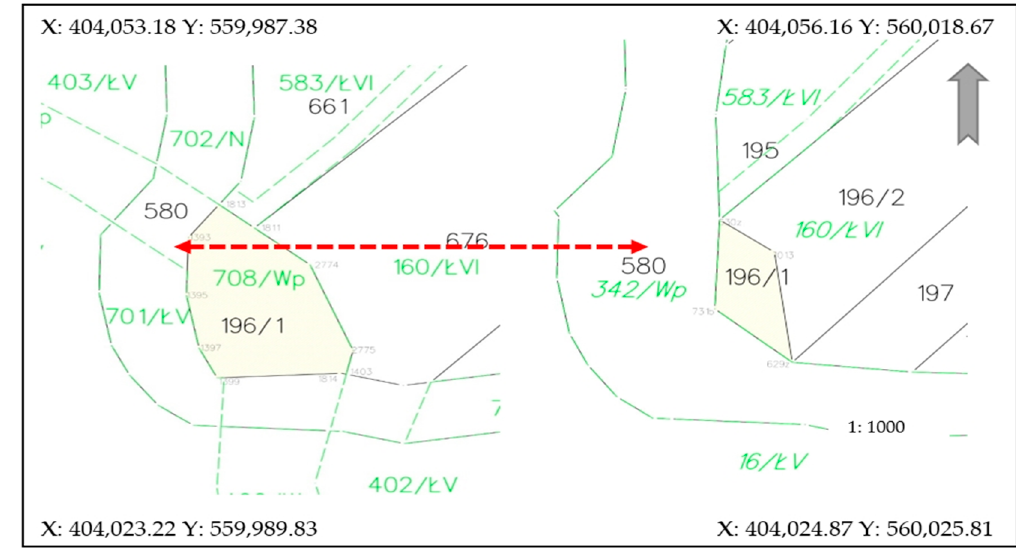
Figure 9. Change in water flow borders after cadastral data modernisation—state before and after modernisation. X, Y—coordinates of the corners of image. Source: own study.